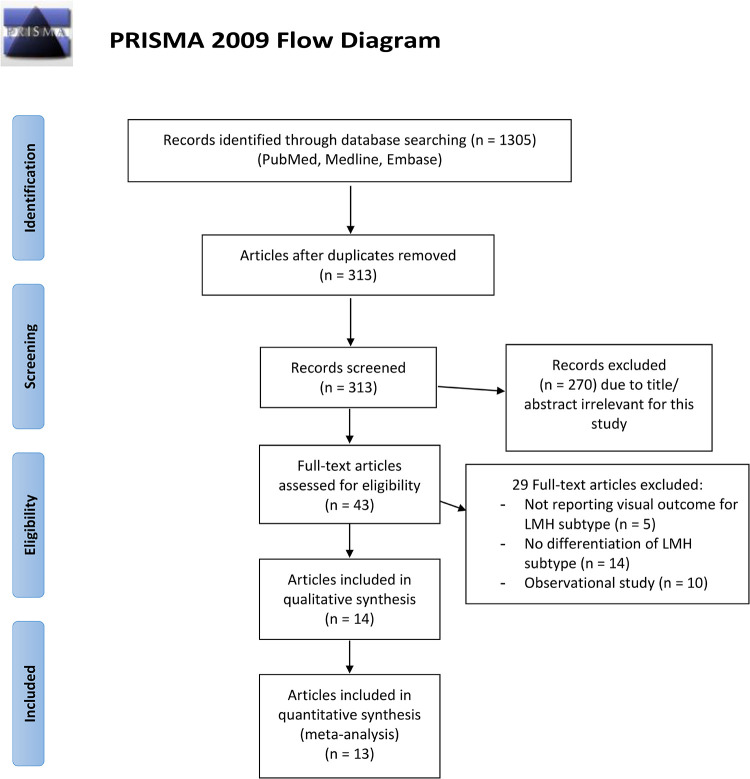
Flow chart of study selection process.From: Moher D, Liberati A, Tetzlaff J, Altman DG, The PRISMA Group (2009). Preferred Reporting Iterns for Systematic Reviews and Meta-Analyses: The PRISMA Statement. PLoS Med 6(7): e1000097. doi: 10.1371/journal.pmed1000097
For more information, visit
www.prisma-statement.org.